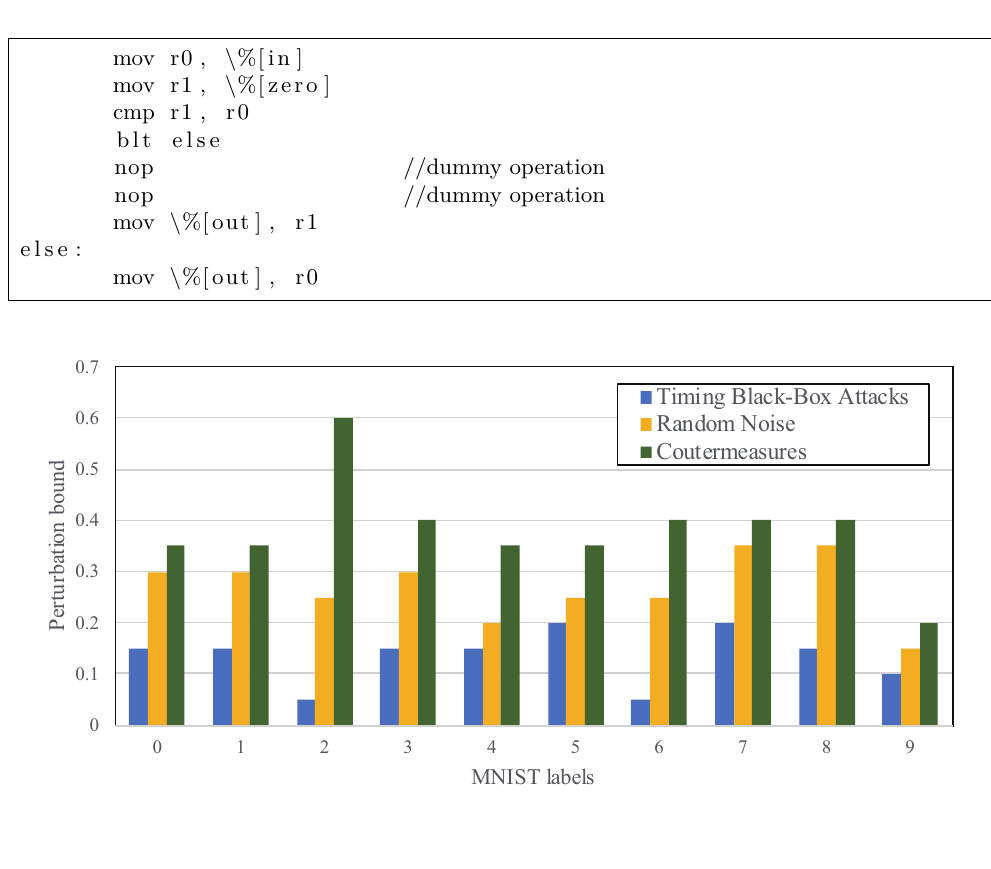
Figure 16: Comparison of timing black-box attacks and